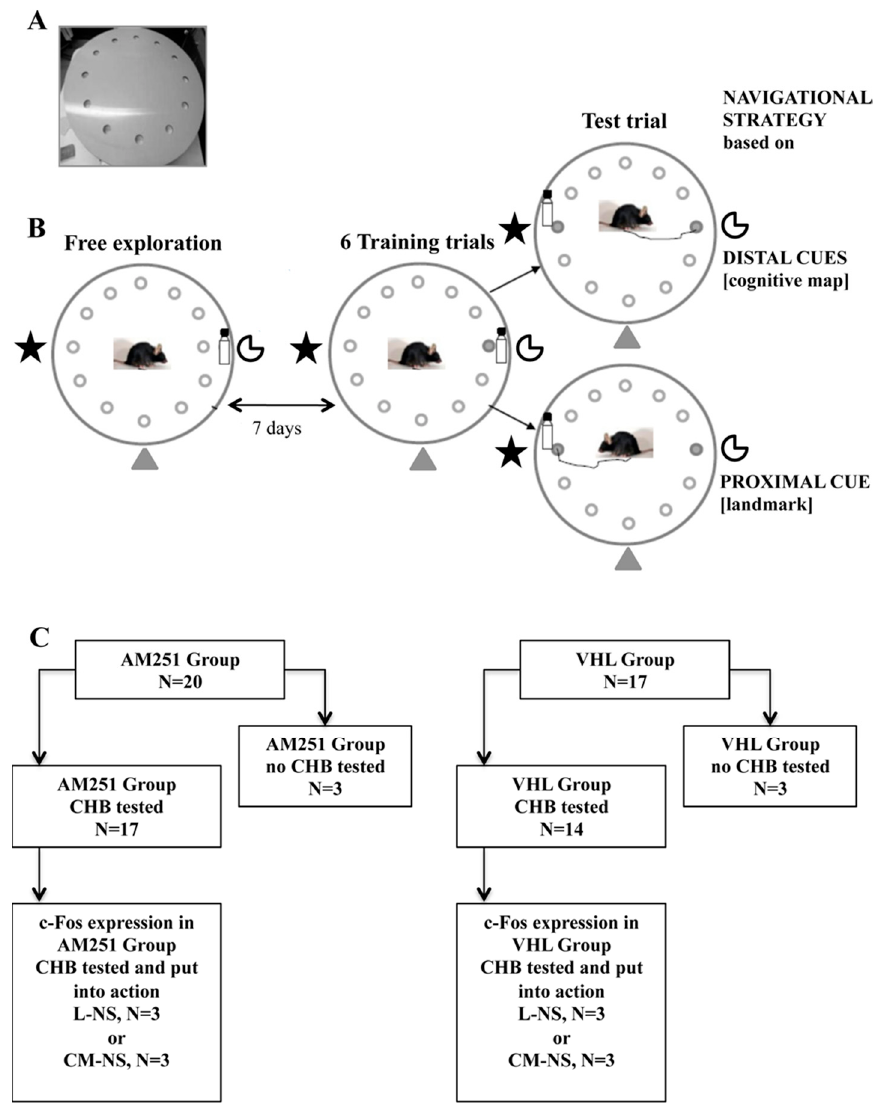
Figure 1. Circular Hole Board (CHB). ( A ) apparatus. ( B ) experimental procedures. ( C ) experimental groups: On the left, animals injected with AM251 (AM251 group, n = 20) and tested ( n = 17) or not ( n = 3) in the CHB. On the right, animals injected with vehicle (VHL group, n = 17) and tested ( n = 3) or not ( n = 3) in the CHB. To analyze c-Fos expression, we selected six animals (of which three belonging to the AM251 group and three to the VHL group) that used the Landmark-related Navigational Strategy (L-NS) in the CHB, and six animals (of which three belonging to the AM251 group and three to the VHL group) that used the Cognitive Map-related Navigational Strategy (CM-NS) in the CHB.